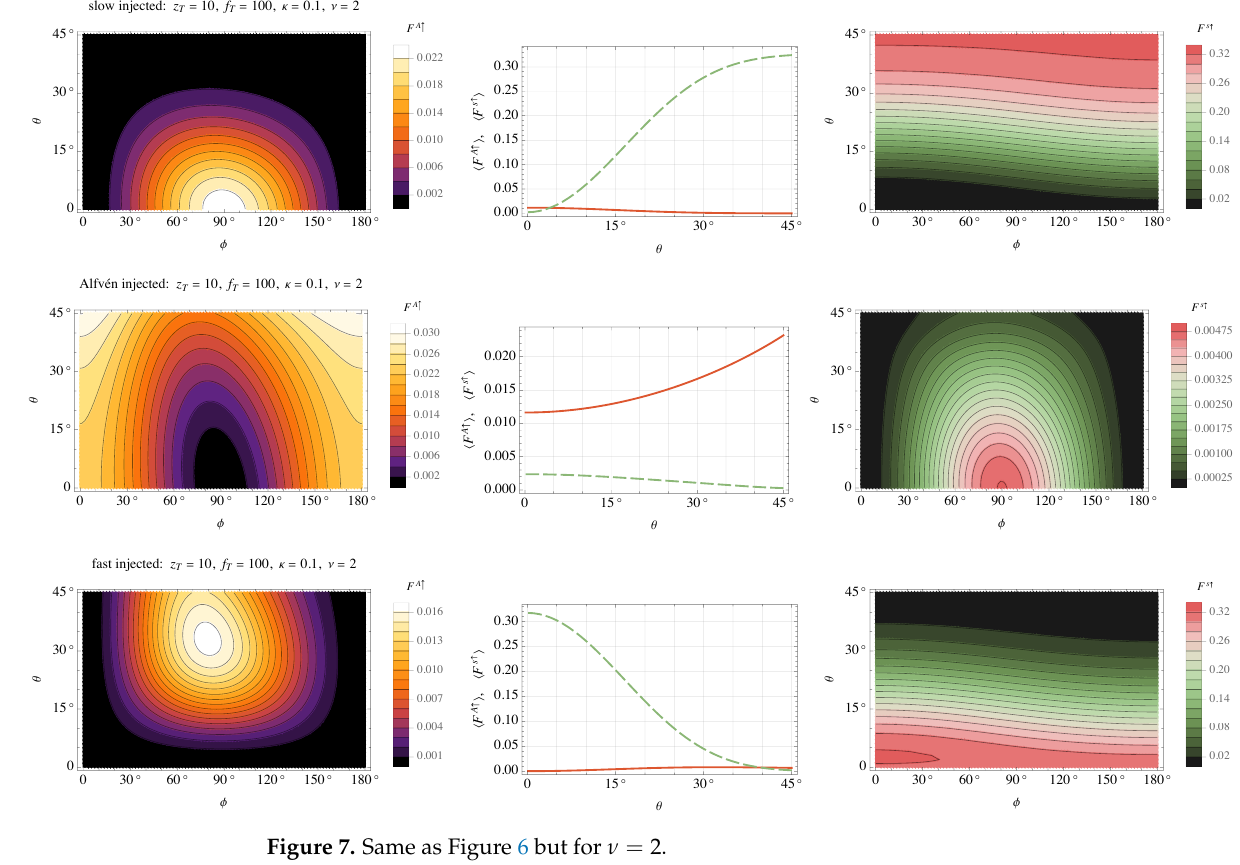
Figure 7. Same as Figure 6 but for ν =